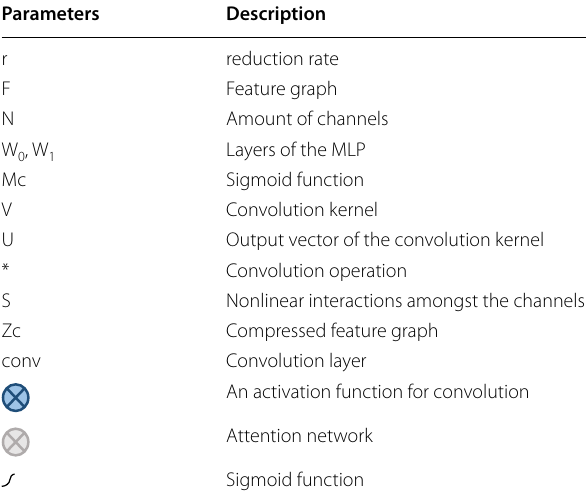
Table 1 List of notations and symbols used in the paper and images